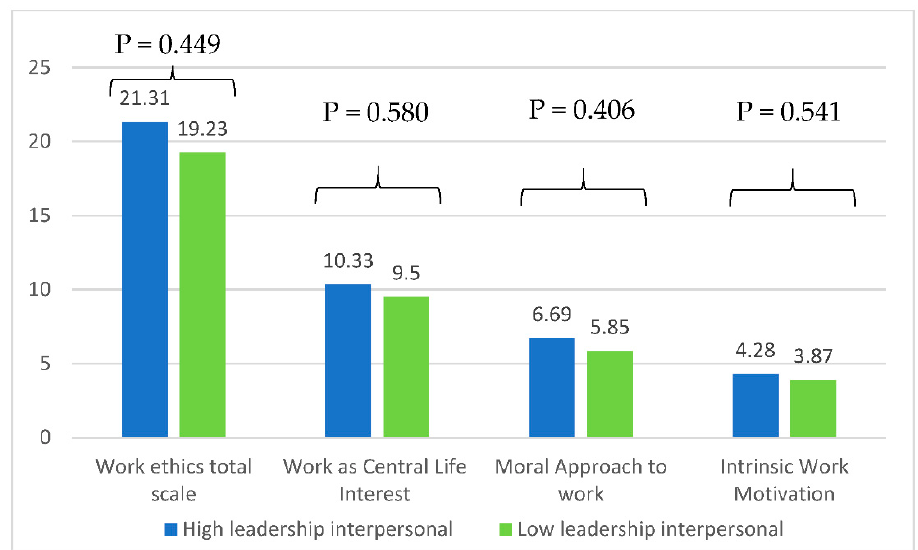
Figure 2. Mean values of the work ethics scale according to high/low interpersonal leadership skills adjusted for age, gender, education level, and years of experience. Table 5. Multivariable